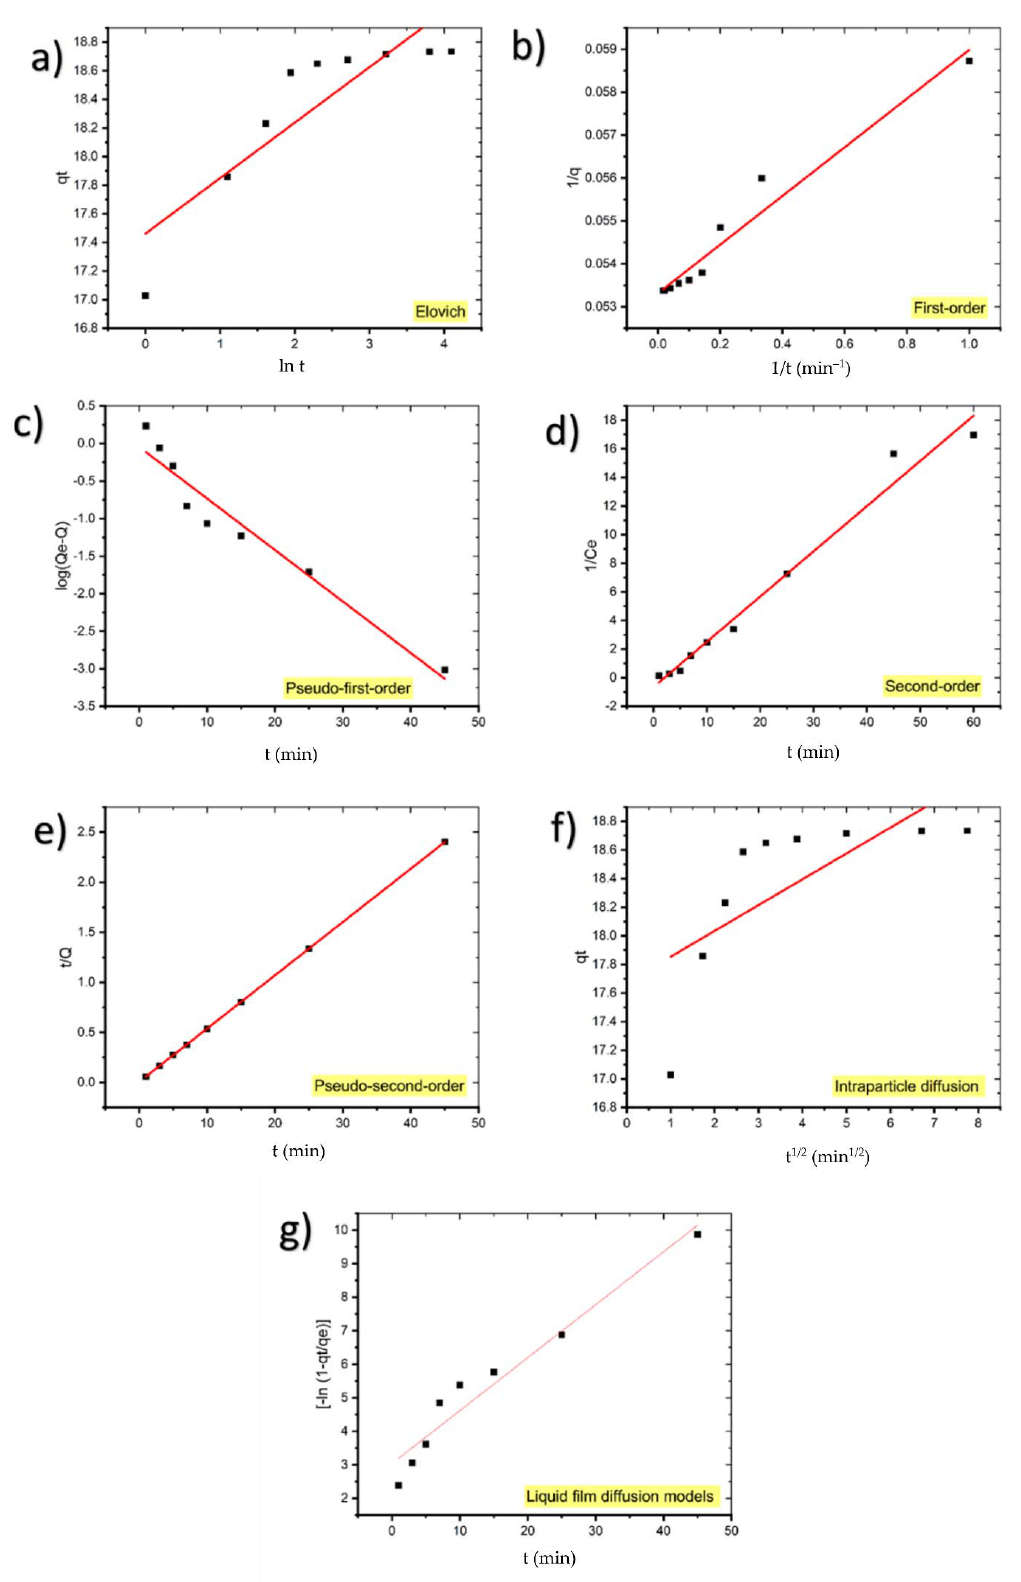
Figure 8. Kinetic models for the adsorption of MB onto coal: ( a ) Elovich, ( b ) first-order, ( c ) pseudo- first-order, ( d ) second-order, ( e ) pseudo-second-order, ( f ) intraparticle diffusion, and ( g ) liquid film diffusion